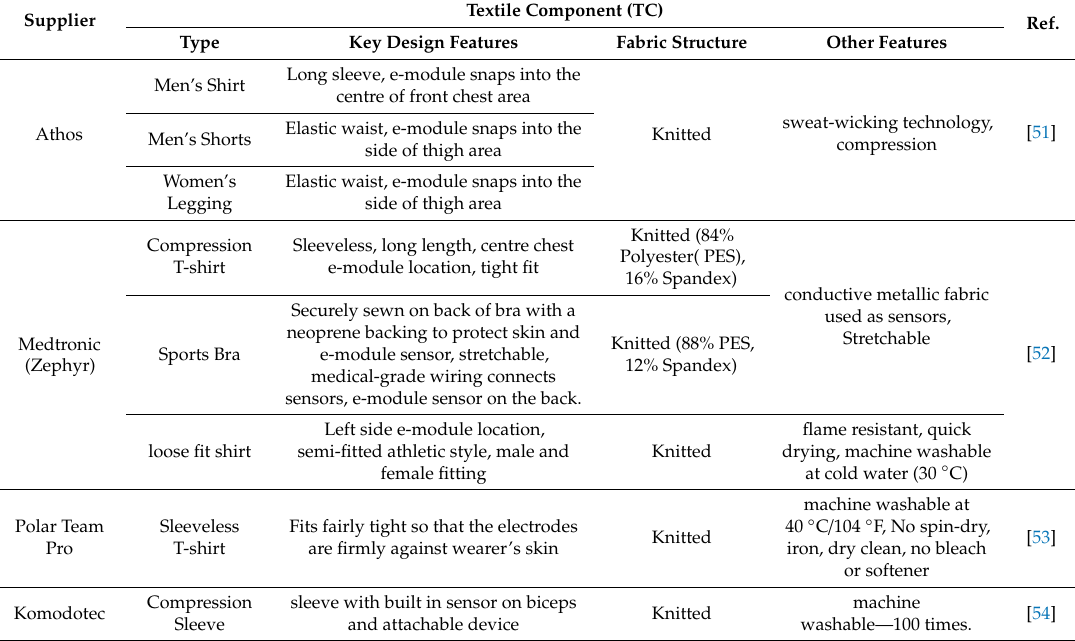
Table 4. Features of the textile components (TCs) of available SeCSs for sports training.